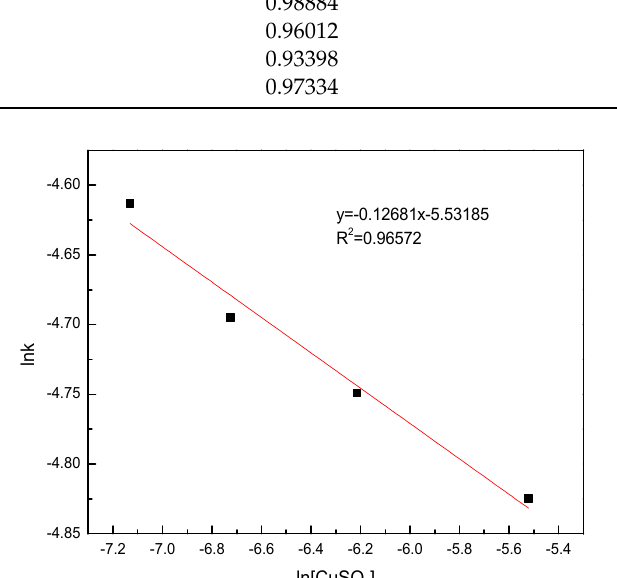
Figure 11. Plot of lnk vs. lnC CuSO4 for the determination of reaction order.